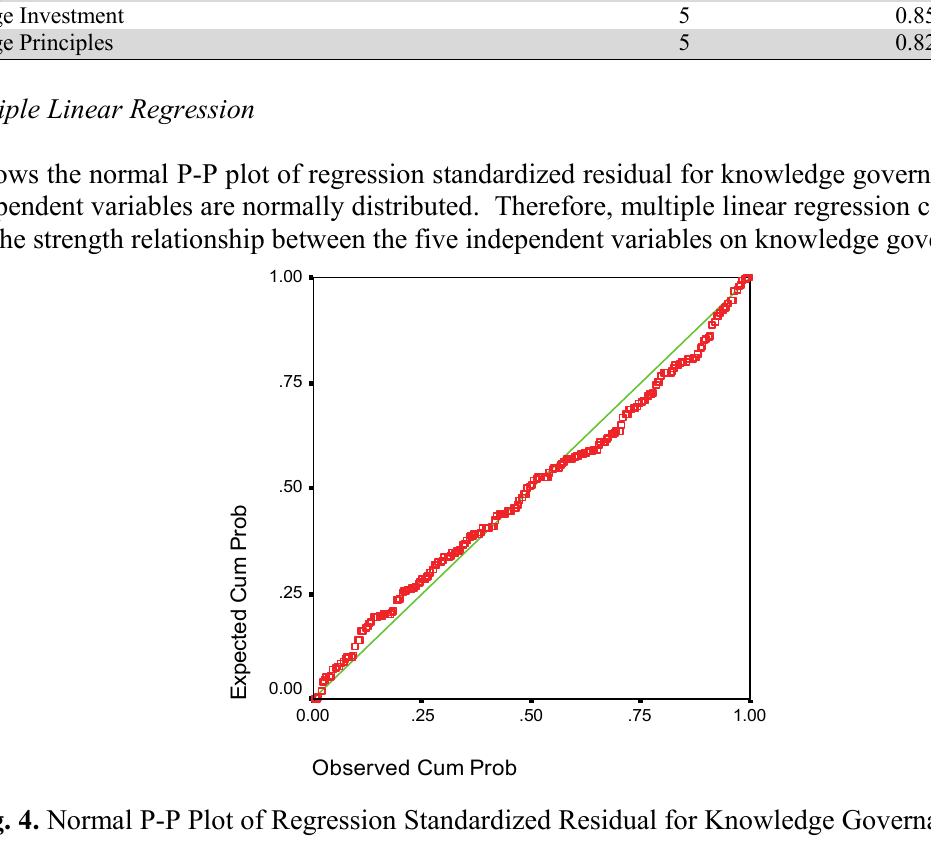
MLR for Knowledge Governance